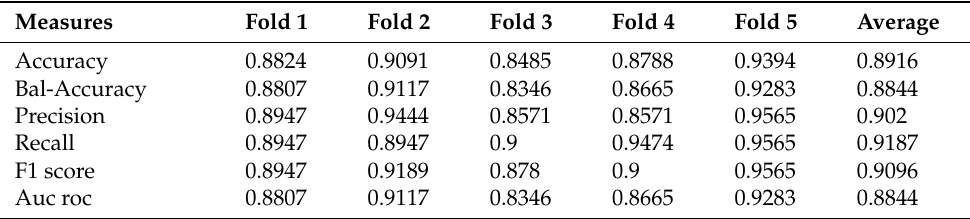
Table 3. K-folds performance results using InceptionResnetV2 .